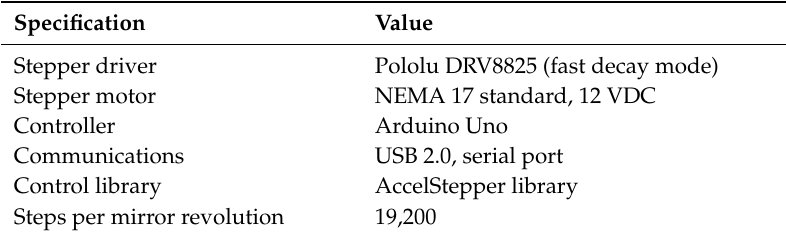
Table 4. Component specifications for the actuator